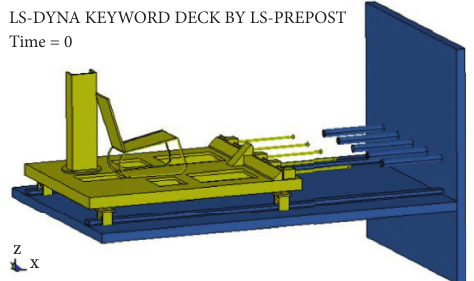
Figure 8: Sled crash simulation model.